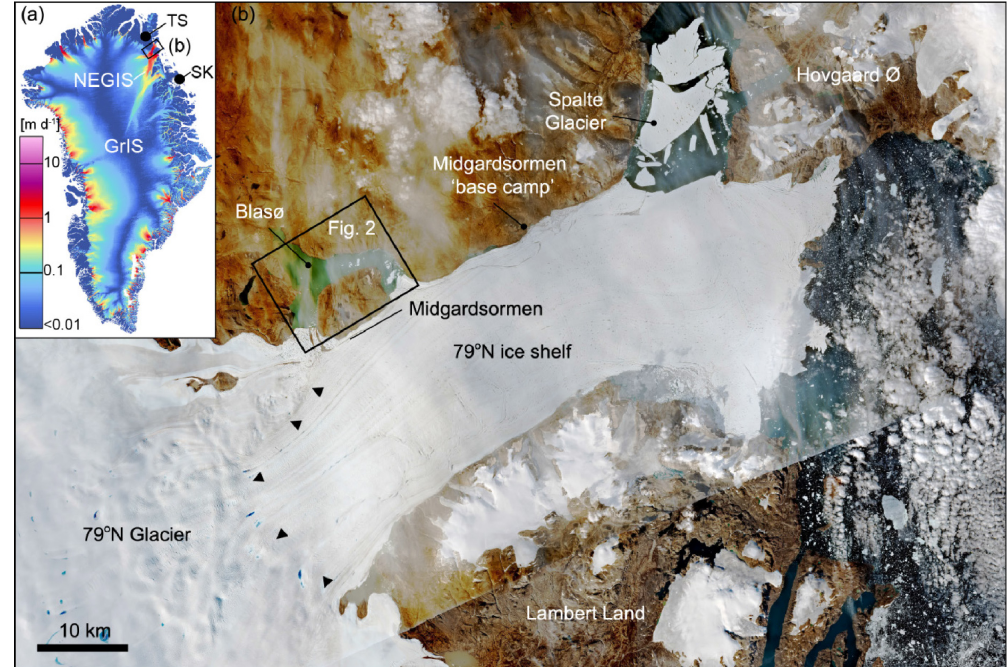
Figure 1. (a) Ice velocity map of the Greenland Ice Sheet (GrIS) (Mottram et al., 2019), showing the location of the Northeast Greenland Ice Stream (NEGIS), the study area presented in panel (b) , Trifna Sø (TS), and Store Koldewey/Duck Lake (SK). (b) Sentinel-2 L2A imagery of 79 ◦ N Glacier and its floating ice shelf (contains modified Copernicus Sentinel data, August, 2020, processed by the Sentinel Hub EO Browser; https://www.sentinel-hub.com/, last access: 14 November 2022). Blåsø is located 2–13km from the grounding line (GL) of 79 ◦ N Glacier, delineated by black triangles. The remnants of Spalte Glacier, a northern tributary of 79 ◦ N Glacier which broke up in 2020, is also